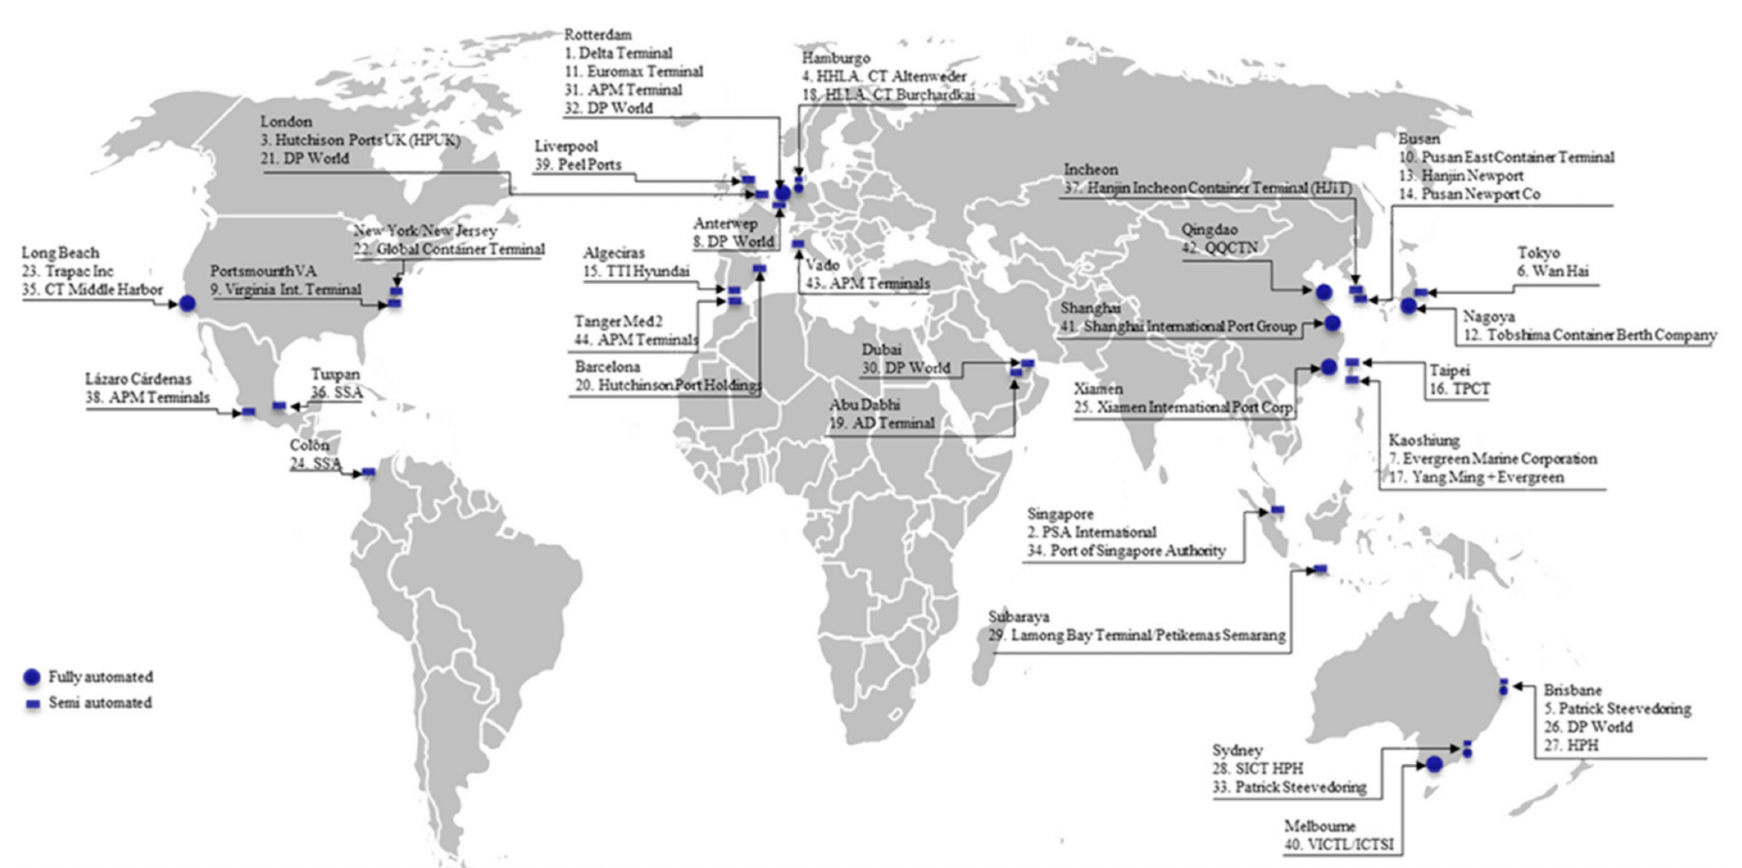
Figure 1. Main automated and semi-automated terminals in the